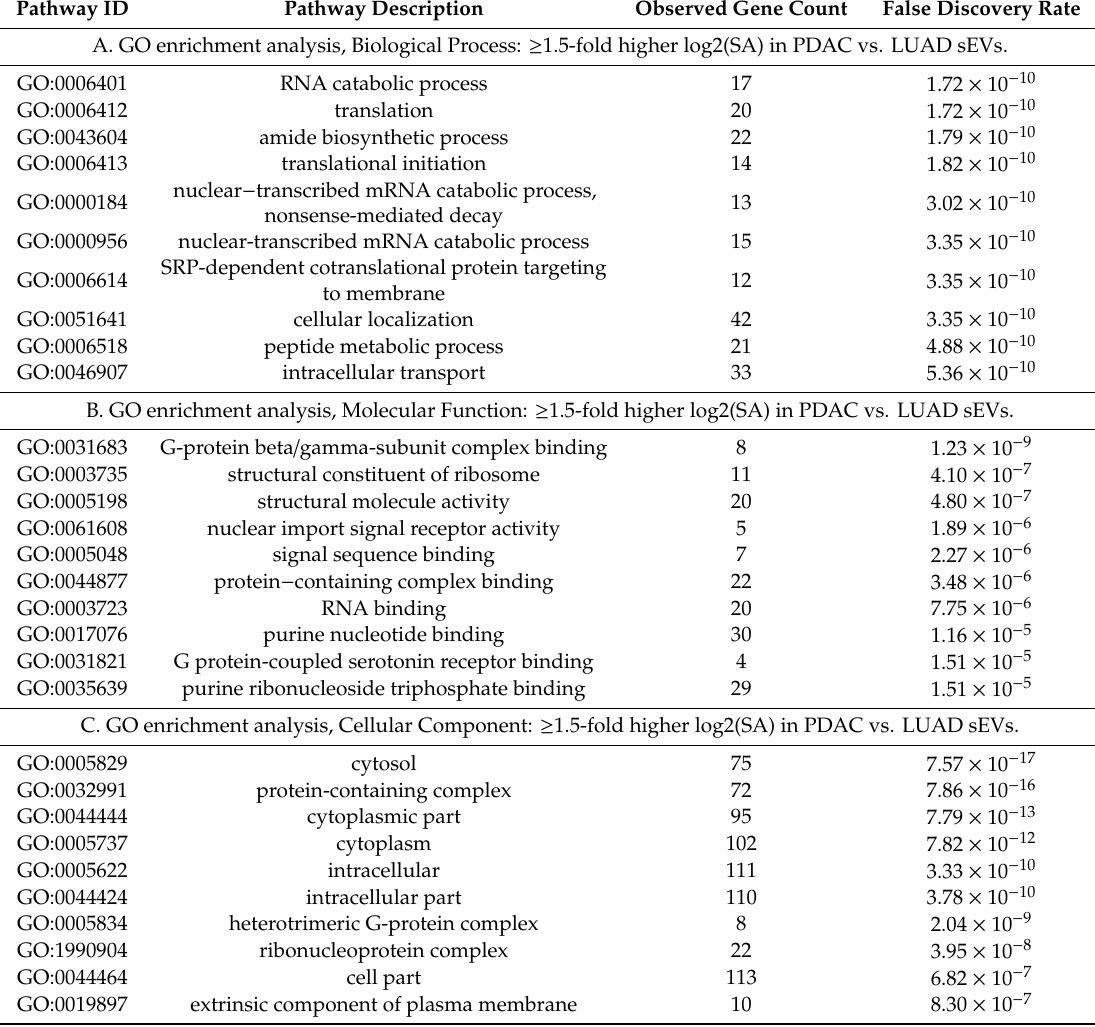
Table A4. GO enrichment analysis of 115 sEV protein features identified with ≥ 1.5-fold higher log2(SA) in PDAC vs LUAD panel cell line sEVs. Top ten statistically enriched GO